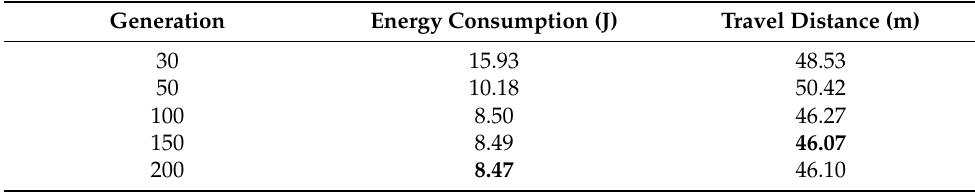
Table 10. Energy consumption and travel distance of the robot when the robot tracks the zigzag path based on optimizing by genetic algorithm. Bold values are the best in the appropriate column.